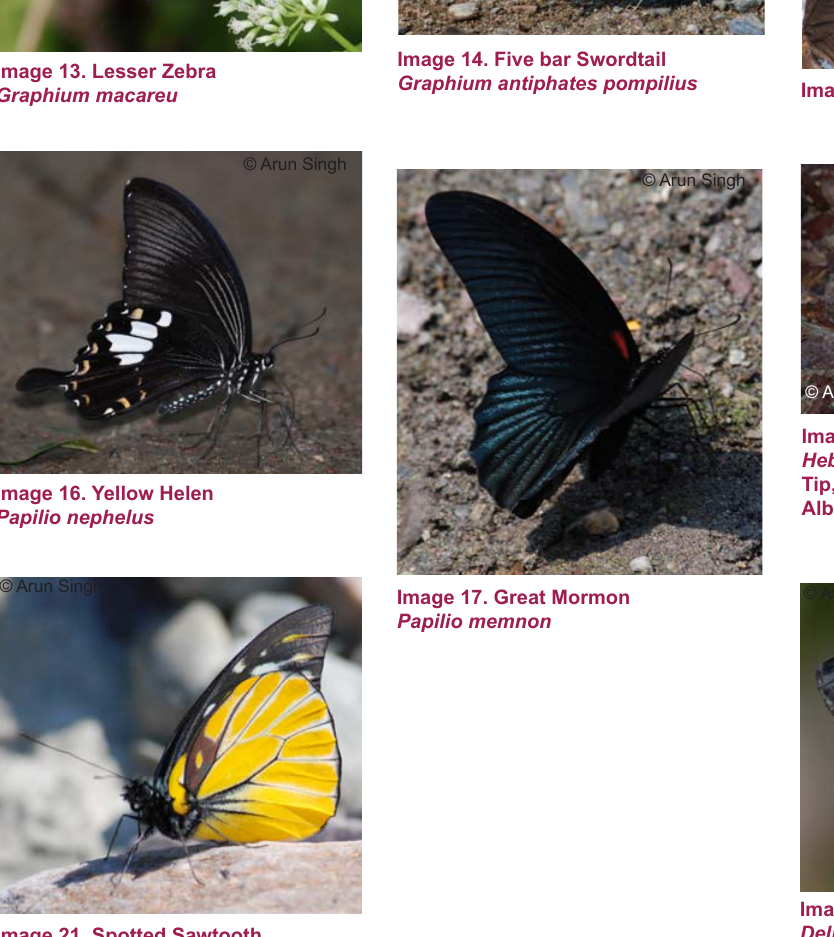
Image 21. Spotted Sawtooth Prioneris thestylis